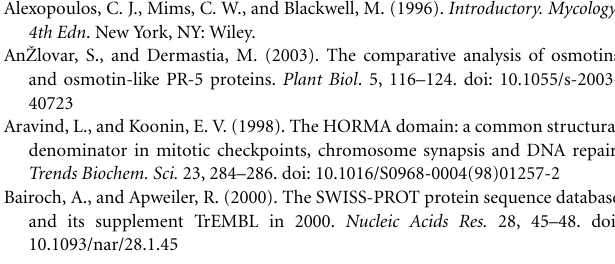
REFERENCES Alexopoulos, C. J., Mims, C. W., and Blackwell, M. (1996). Introductory.